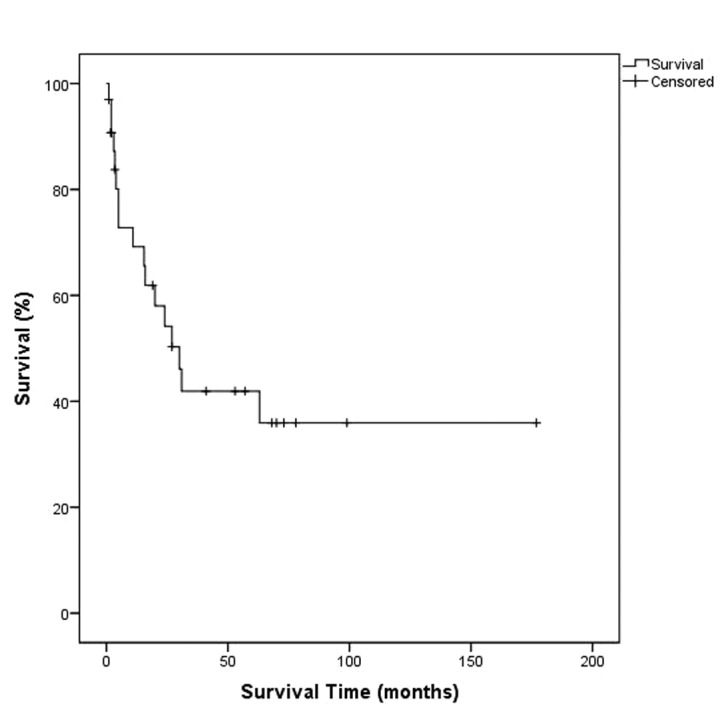
Overall survival.